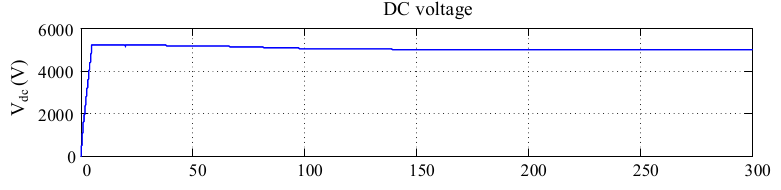
Figure 6. Case 1 DC bus voltage.